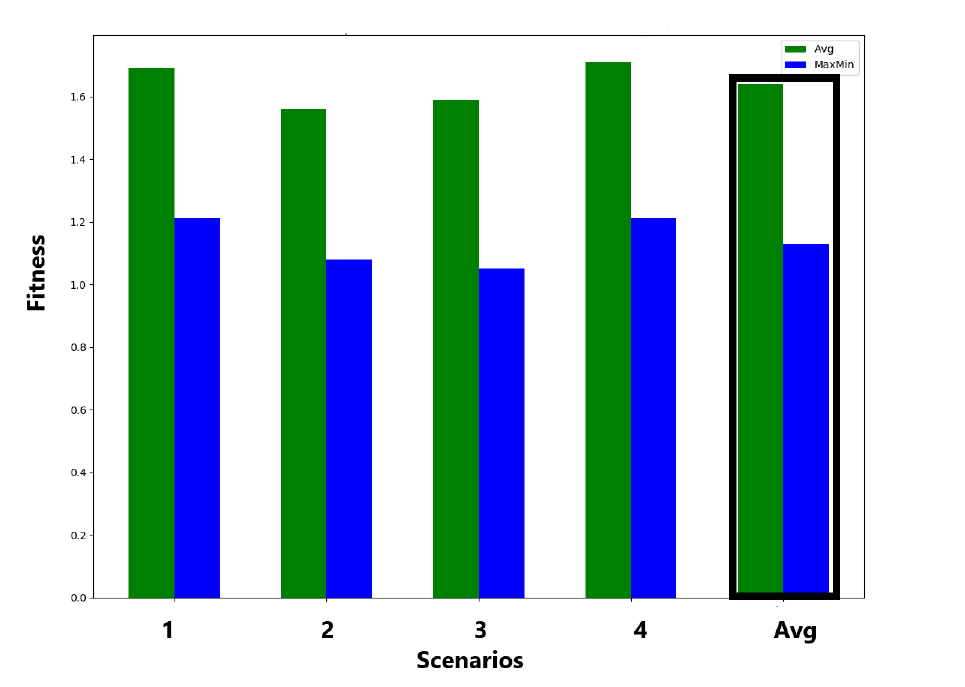
Figure 12. GANet performance when maximizing the average performance across four training scenarios (green) compared to maximizing the minimum performance over four